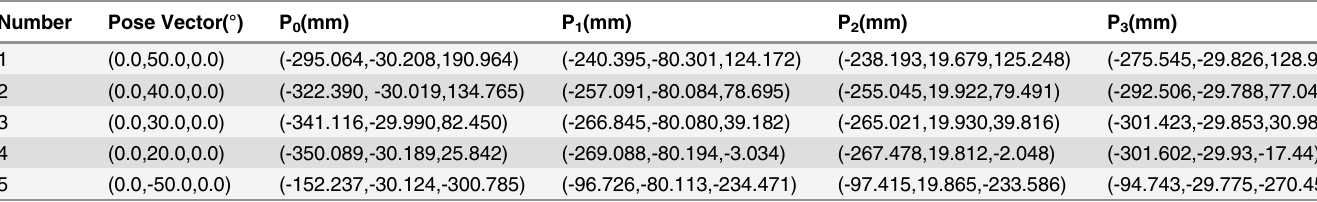
Table 4. Final control point set M IV